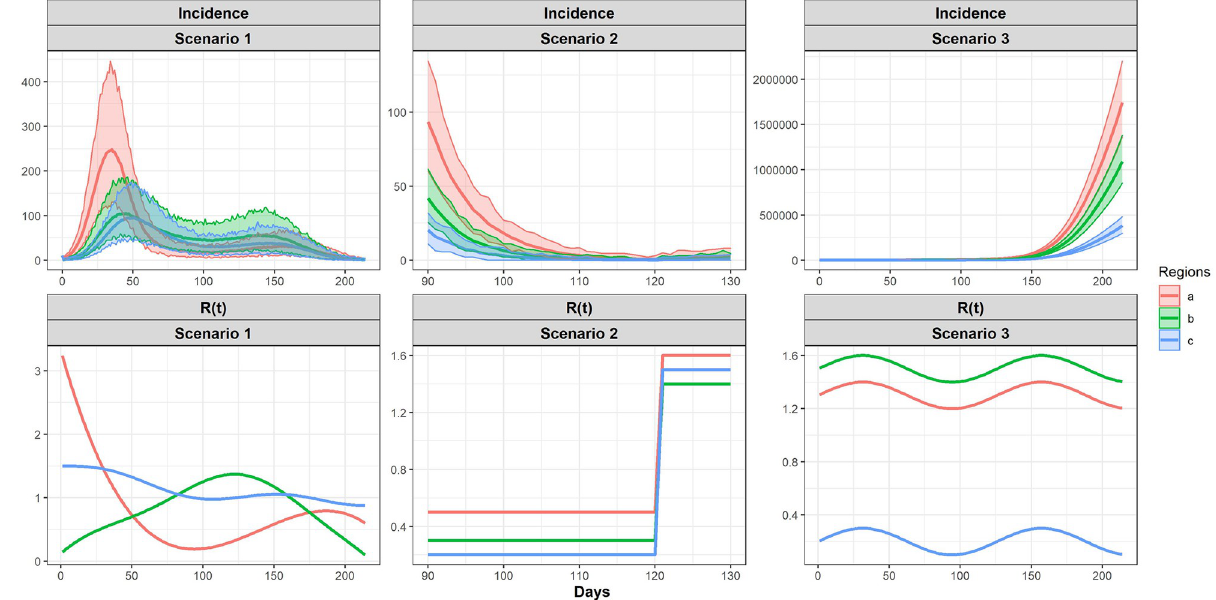
Fig 1. Specified R ( t ) functions and incidence for three regions from 100 replicates for simulation. The top panel shows the simulated incidence of 100 replicates. The shaded areas are the 95% quantile bands of the simulated incidences, the solid lines in the shaded area are the mean of the simulated incidences. The bottom panel shows the specified R ( t ) functions, which are plotted as solid lines. Model 3: constant P matrix, smoothing window is 9, assume Negative Binomial distribution with ϕ � N (0, 5) for N ( t ); j